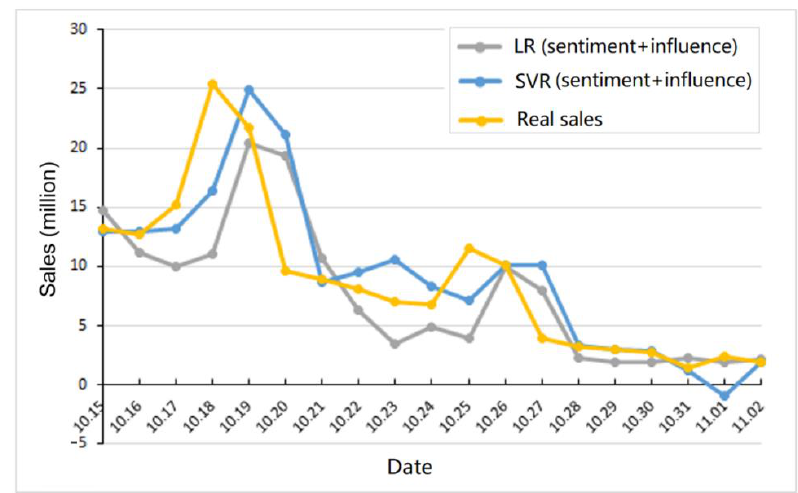
Figure 4. Comparison of the prediction models with real sales.